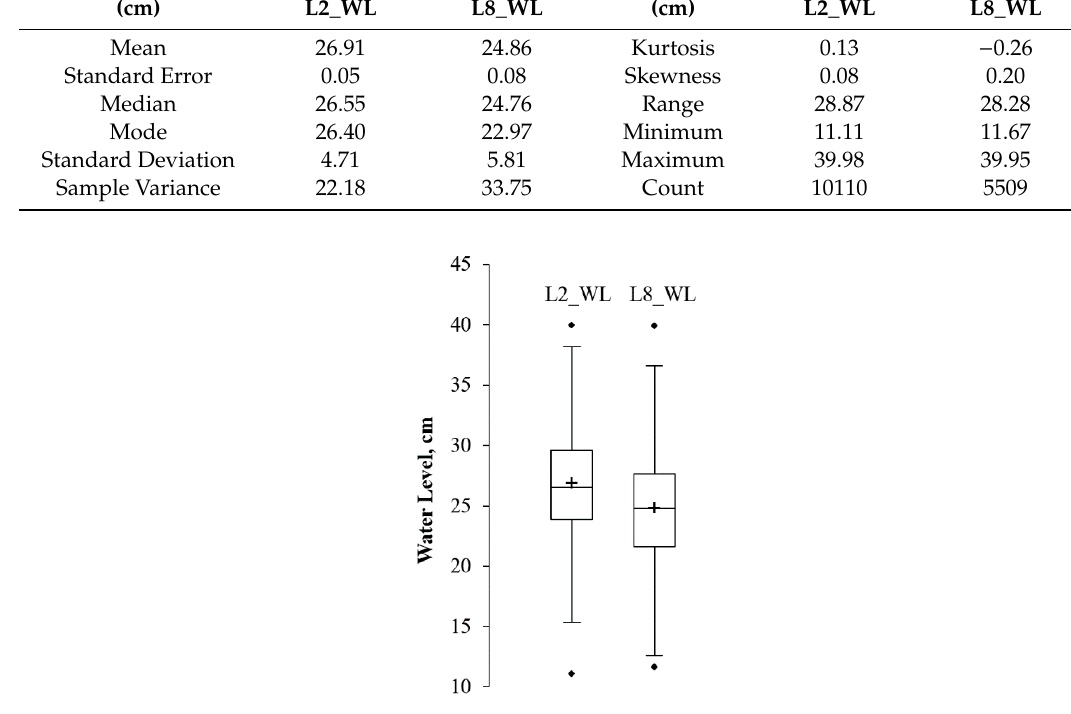
Figure 8. Box plot for L2_WL and L8_WL data.